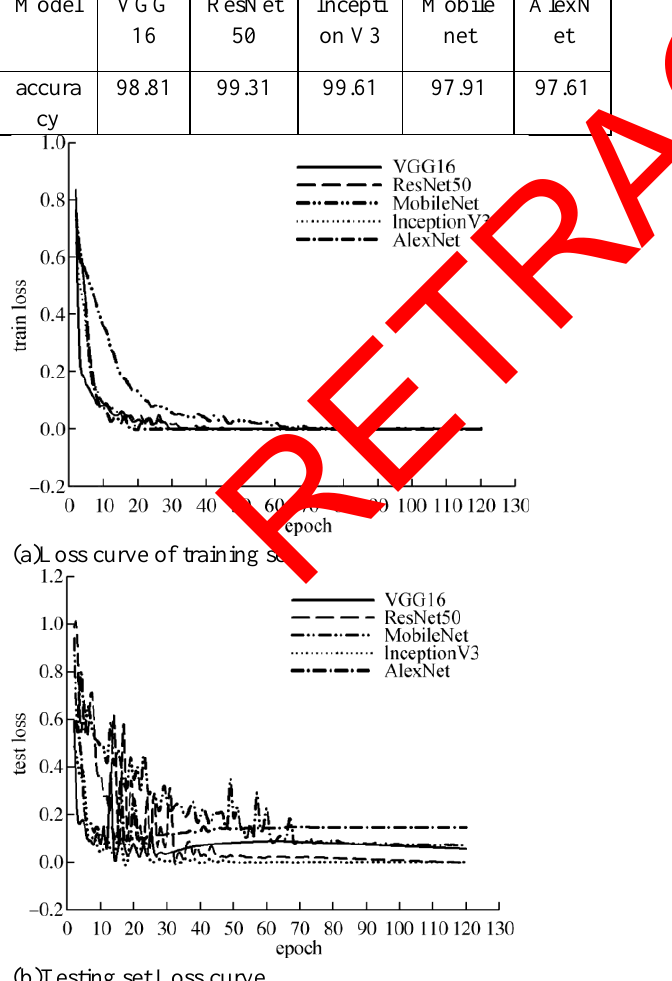
Table 1. Accuracy comparison of the model/%